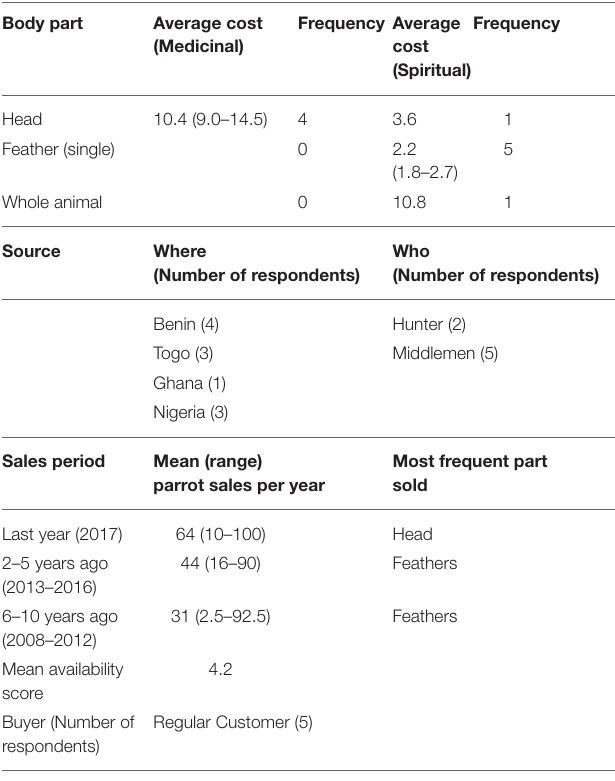
TABLE 1 | Summary of respondent responses to questions regarding trade in Grey parrot ( Psittacus erithacus ) body parts. Body